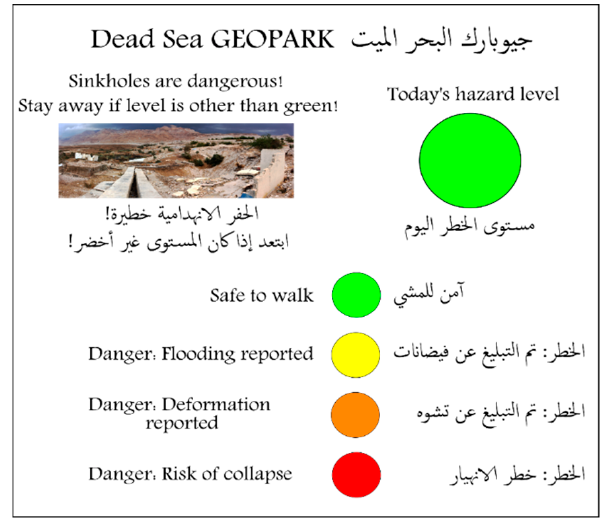
Figure 16. Sign posts related to the warning system at the sinkhole area. A translation of the sign into Arabic is provided to the right side.